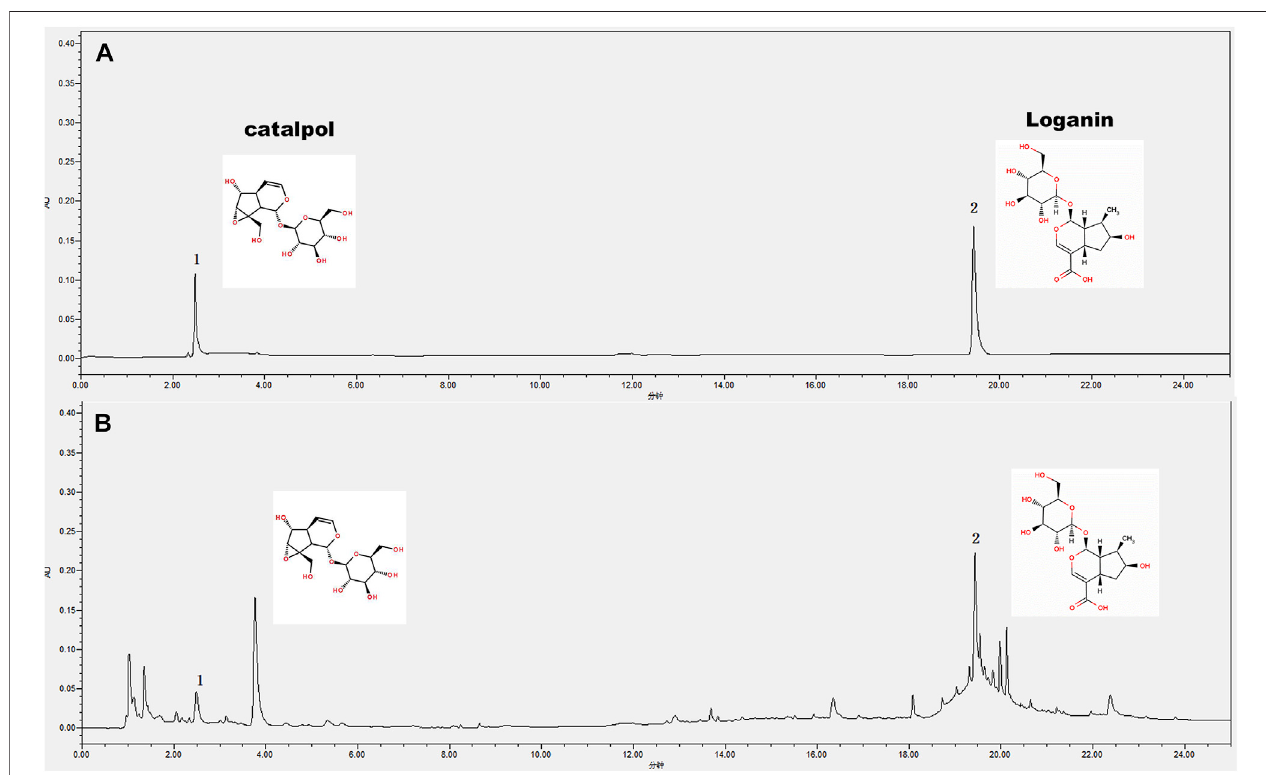
FIGURE1| HPLCChartsfordeterminationofmaincompoundsinRR-COincludingcatalpolandloganin (A) Thecatalpolandloganinstandardsample (B) TheRR- CO decoction.